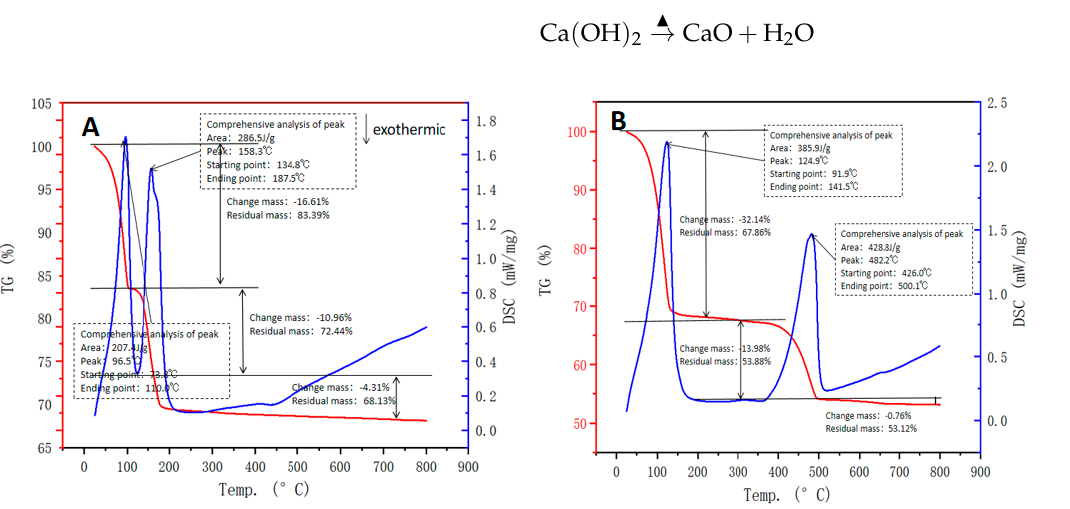
Figure 4. TG-DSC of raw materials ( A -PG, B -CCS).